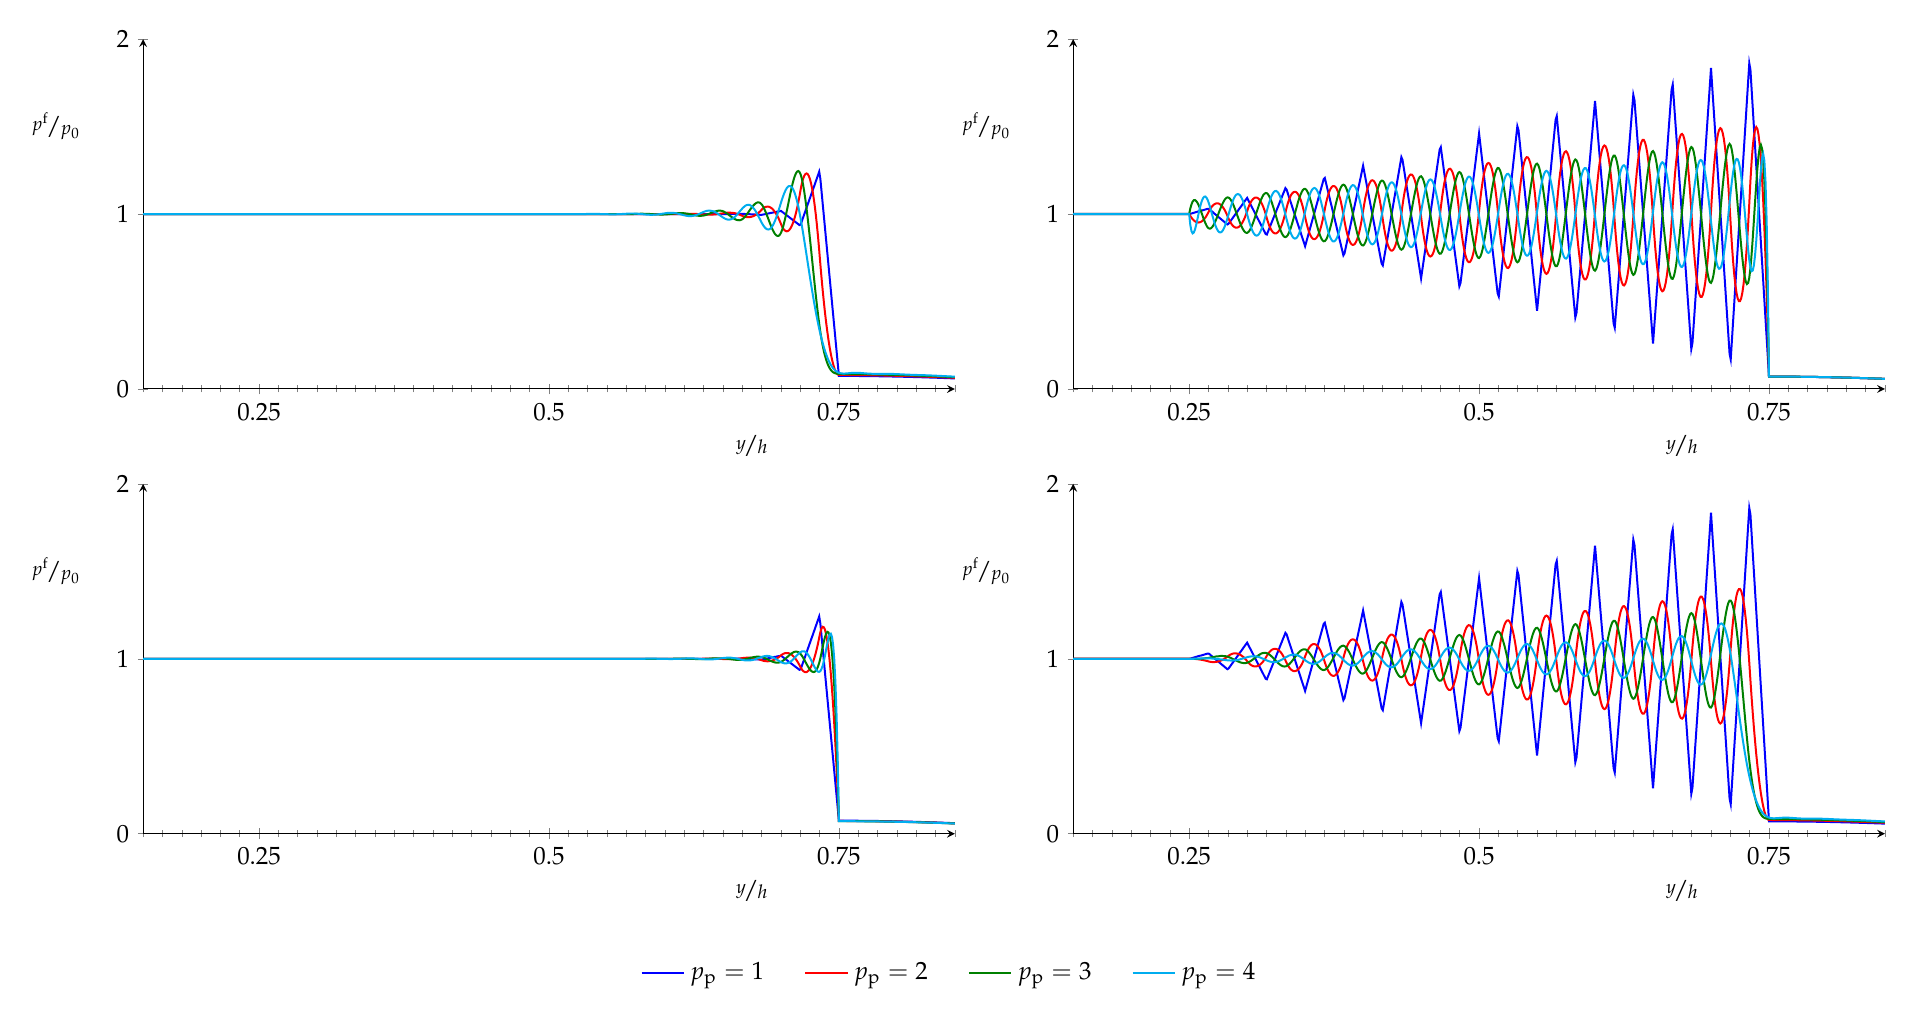
Figure 8. Numerical solution to the Haga problem using N e = 60 uniform elements and ∆ t = 1s. All figures are shown after two time steps. On the left the mixed order method, and on the right the equal order method. The continuity in the boundary layer is C p p − 1 in the top row, and C 0 in the bottom